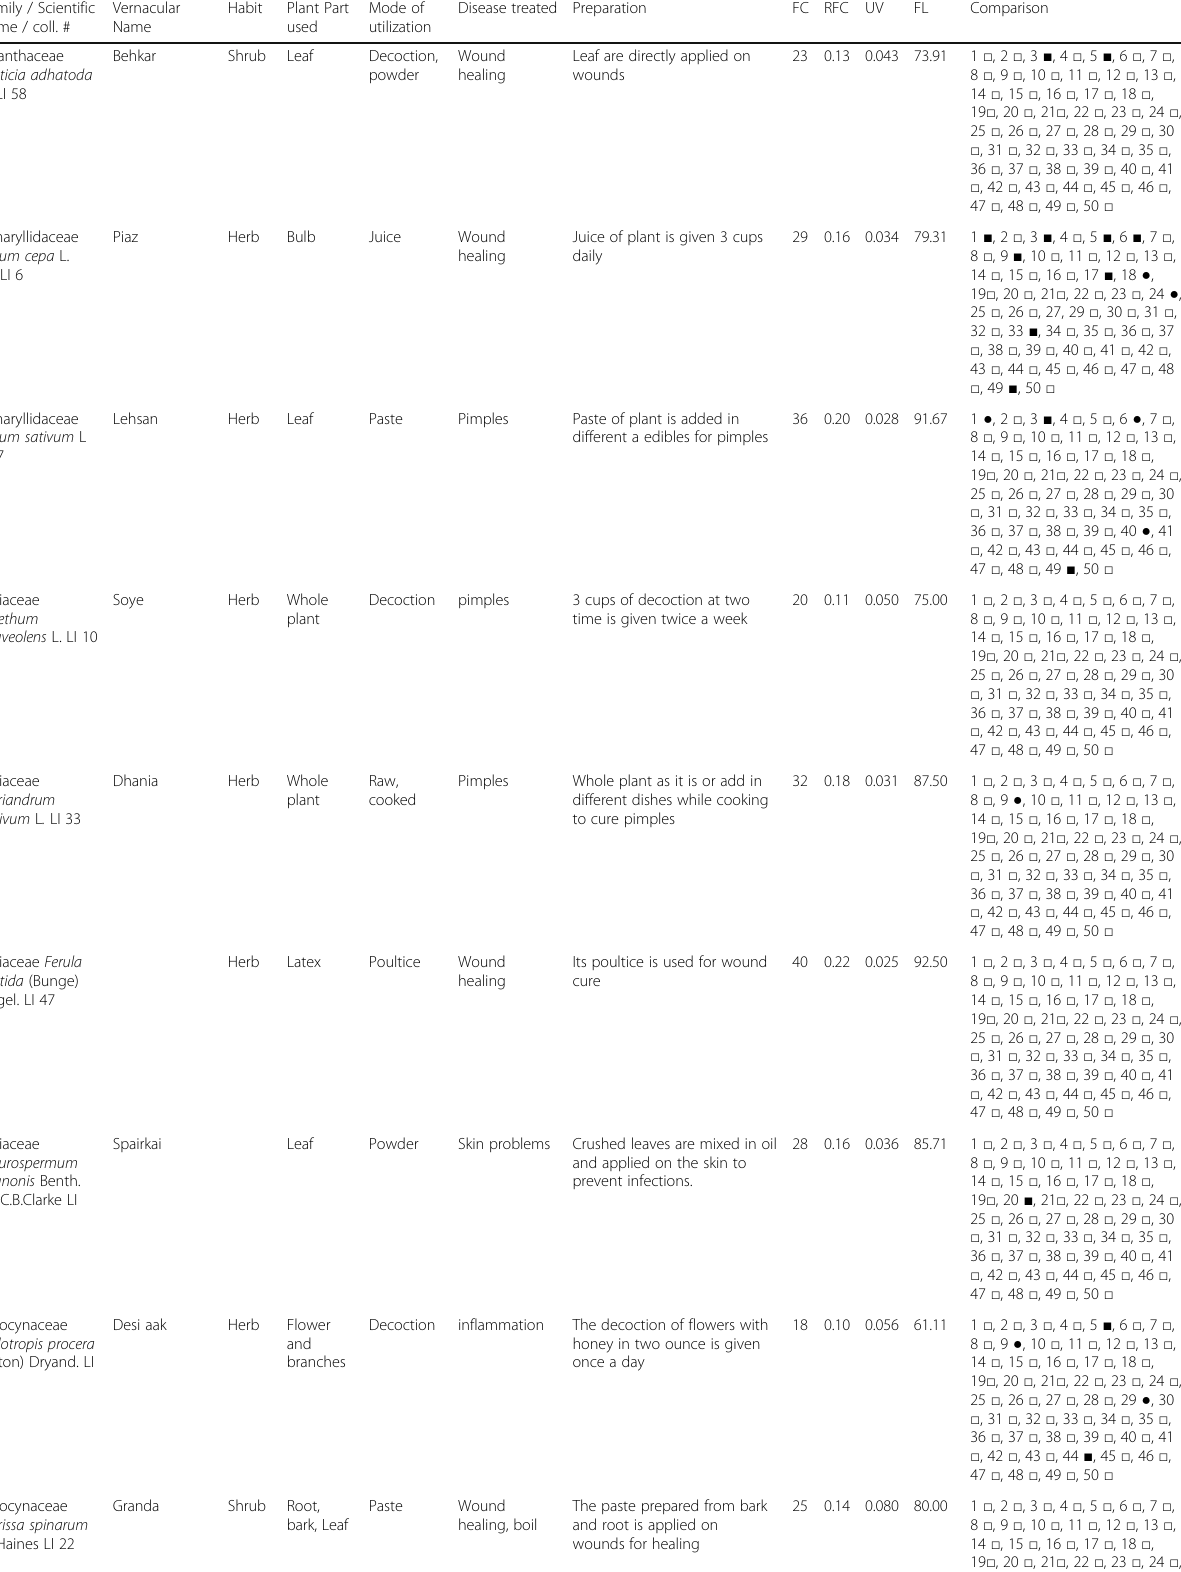
Table 2 Medicinal plants used for skin diseases in Northern Pakistan Family / Scientific name / coll.